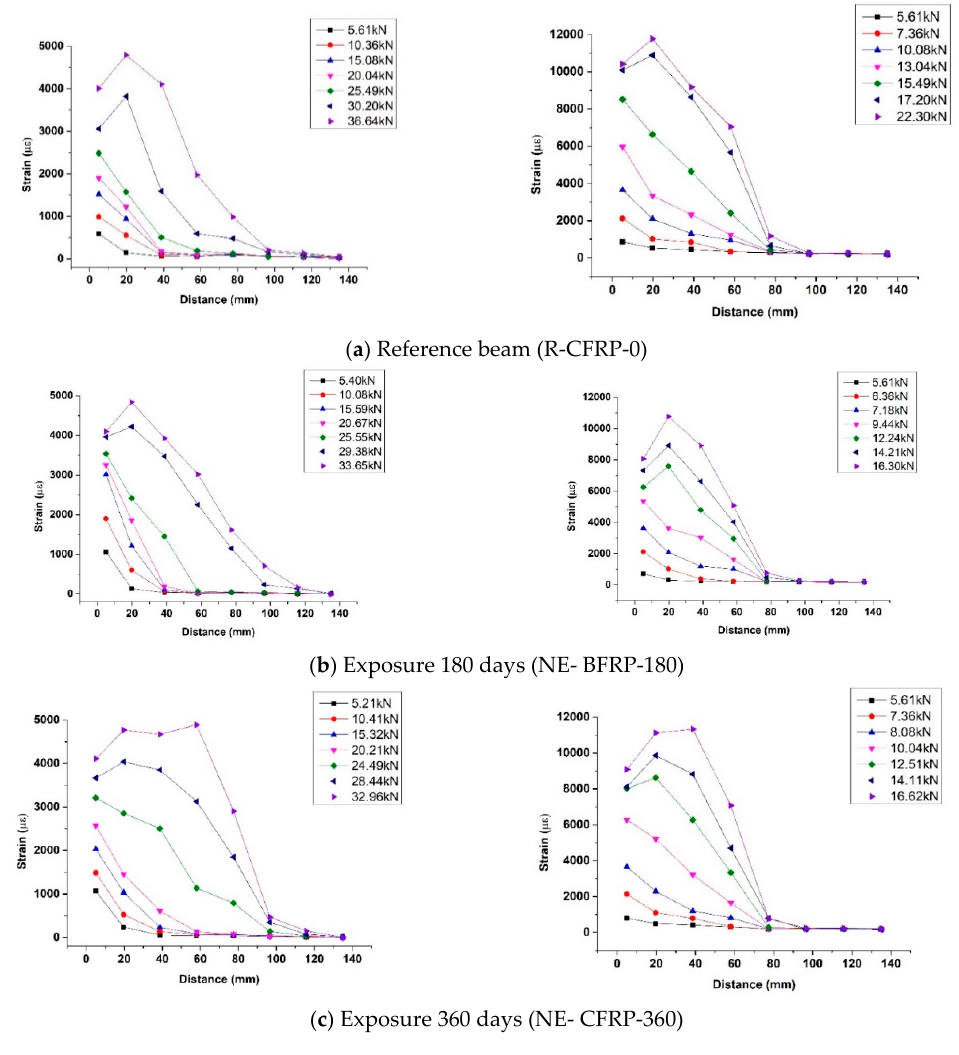
Figure 12. Strains on